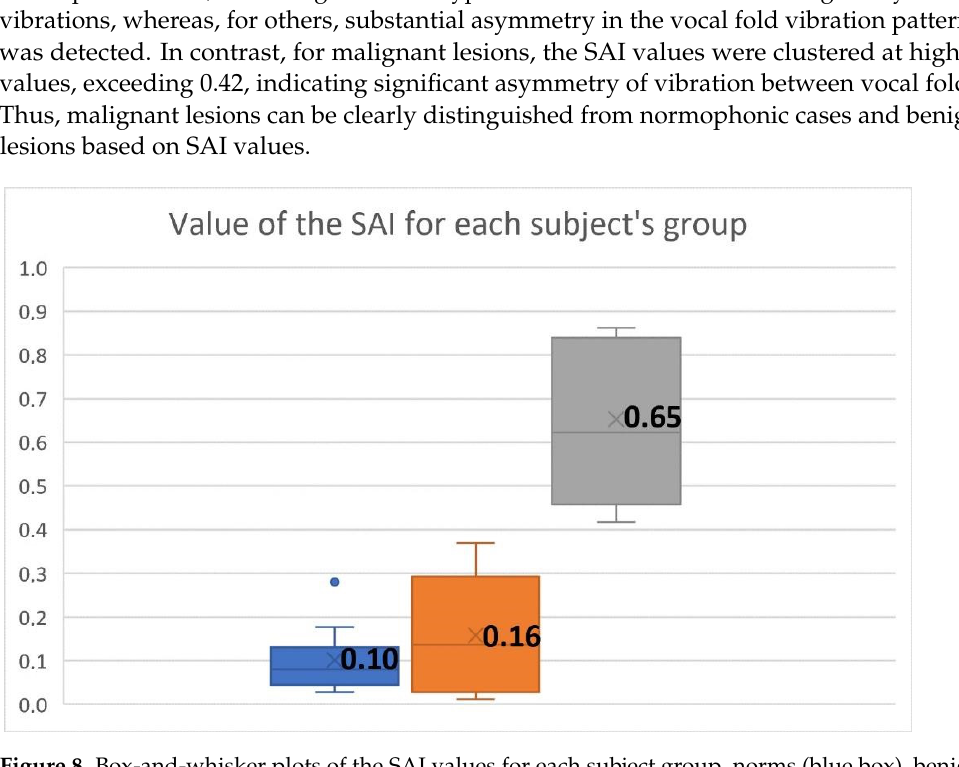
Figure 8. Box-and-whisker plots of the SAI values for each subject group, norms (blue box), benign (orange box), and malignant (gray box). The blue dot corresponds to an elevated SAI obtained for a single subject with a normophonic voice.